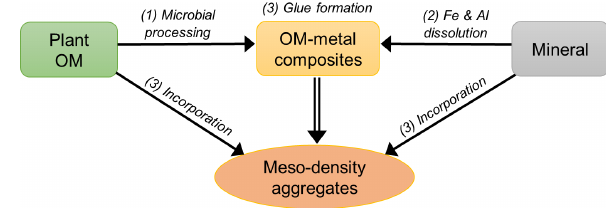
Figure 9. Conceptual illustration of meso-density aggregate for- mation. The three main processes are (1) microbial processing of plant-derived organic matter, (2) metal dissolution via chemical weathering, and (3) the formation of organo-metallic glue, which promote meso-density microaggregate formation by incorporating some POM and